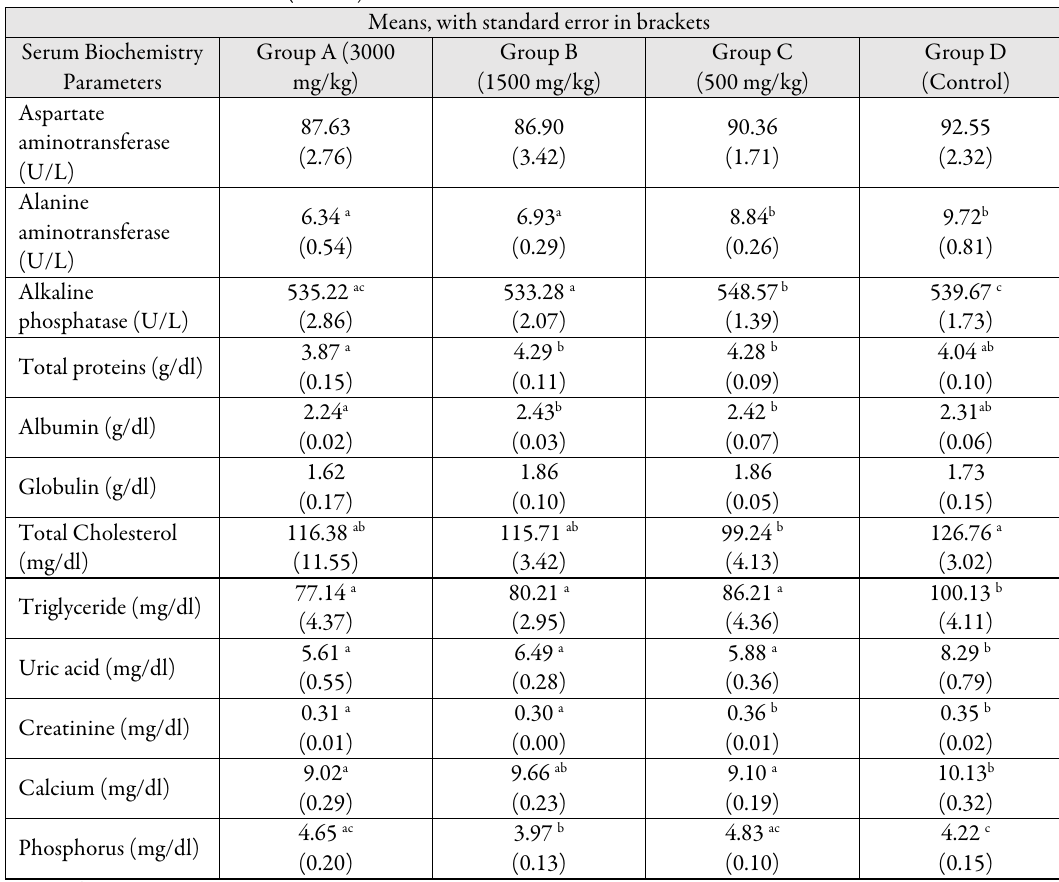
Table 3. Serum biochemistry alterations in groups of cockerels given varied doses of